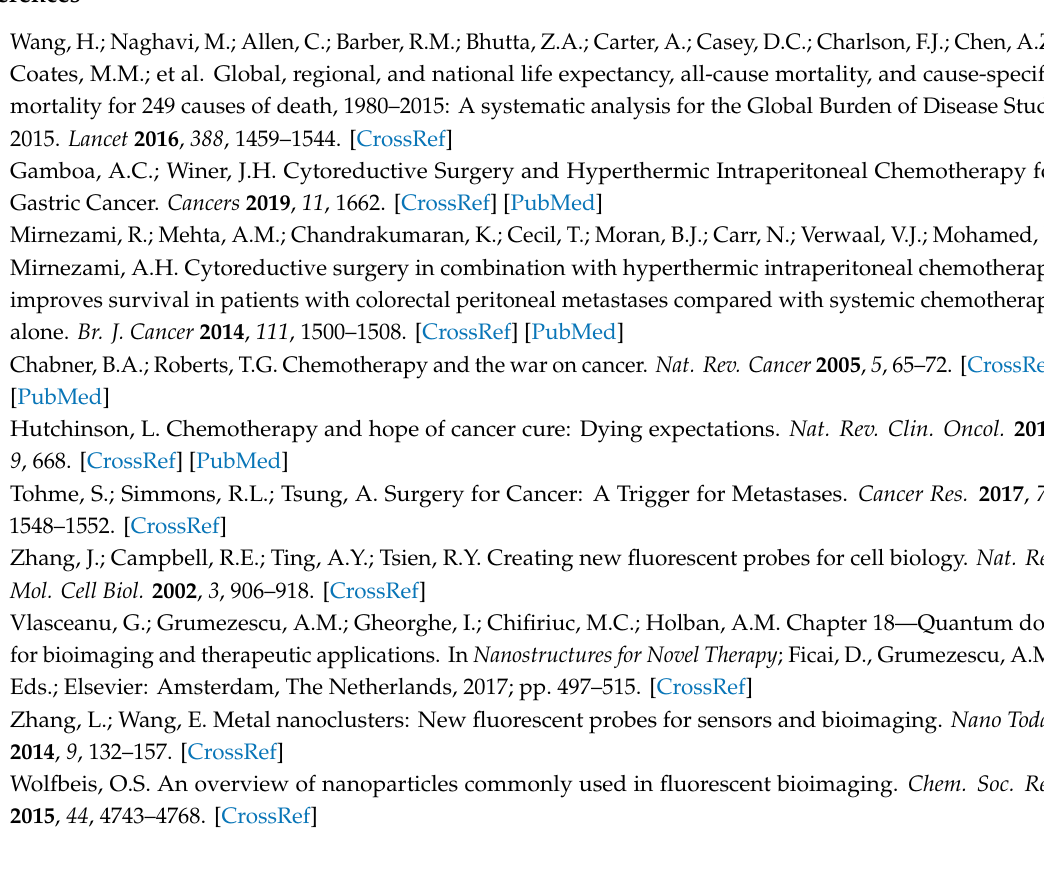
Figure S1: Absorption spectra of Pd NCs in various biological media medium, Figure S2: Stability of Pd NCs in DMEM cell culture medium with and without 10%